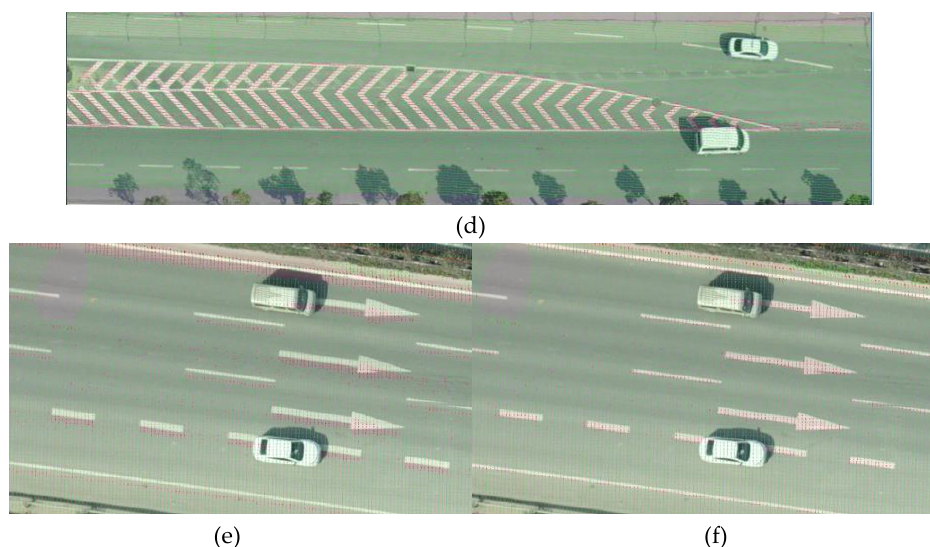
Figure 11. Land mark back projection: (a)–(b) Entry entrance line before and after LiDAR constrain; (c)–(d) diverging line before and after LiDAR constrain; (e)–(f) indicating arrow before and after LiDAR constrain.